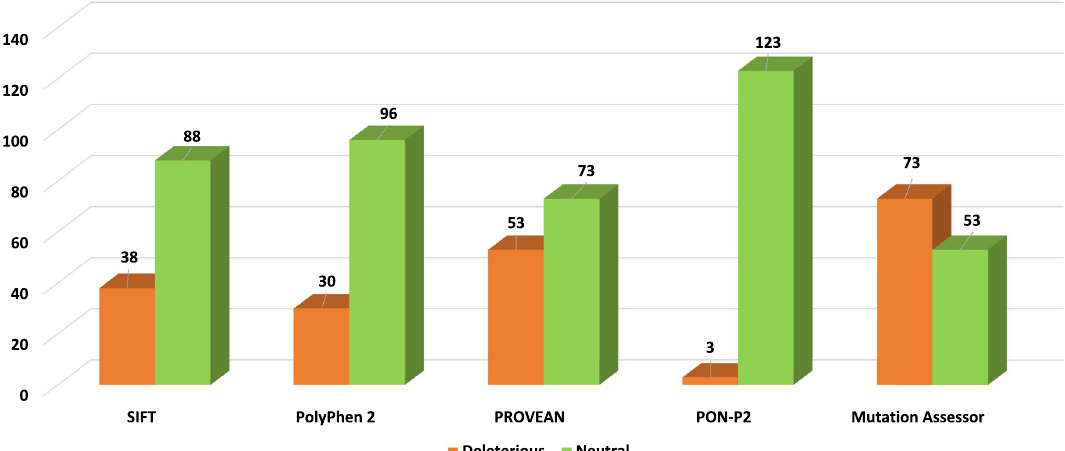
Figure 5. Distribution of deleterious and neutral nsSNPs predicted by sequence-based tools for the C-terminal OB-fold region of CTC1 protein. The vertical axis shows the number of mutations. The horizontal axis shows the sequence-based tools; the orange bar depicts the number of predicted deleterious mutations, and the green bar depicts the number of predicted non-deleterious mutations.